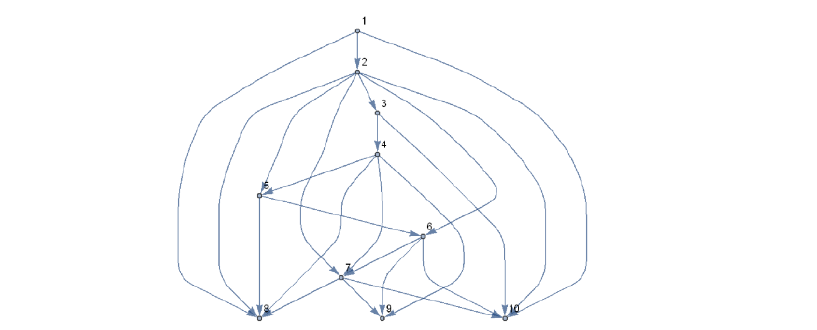
Figure 5. Transportation